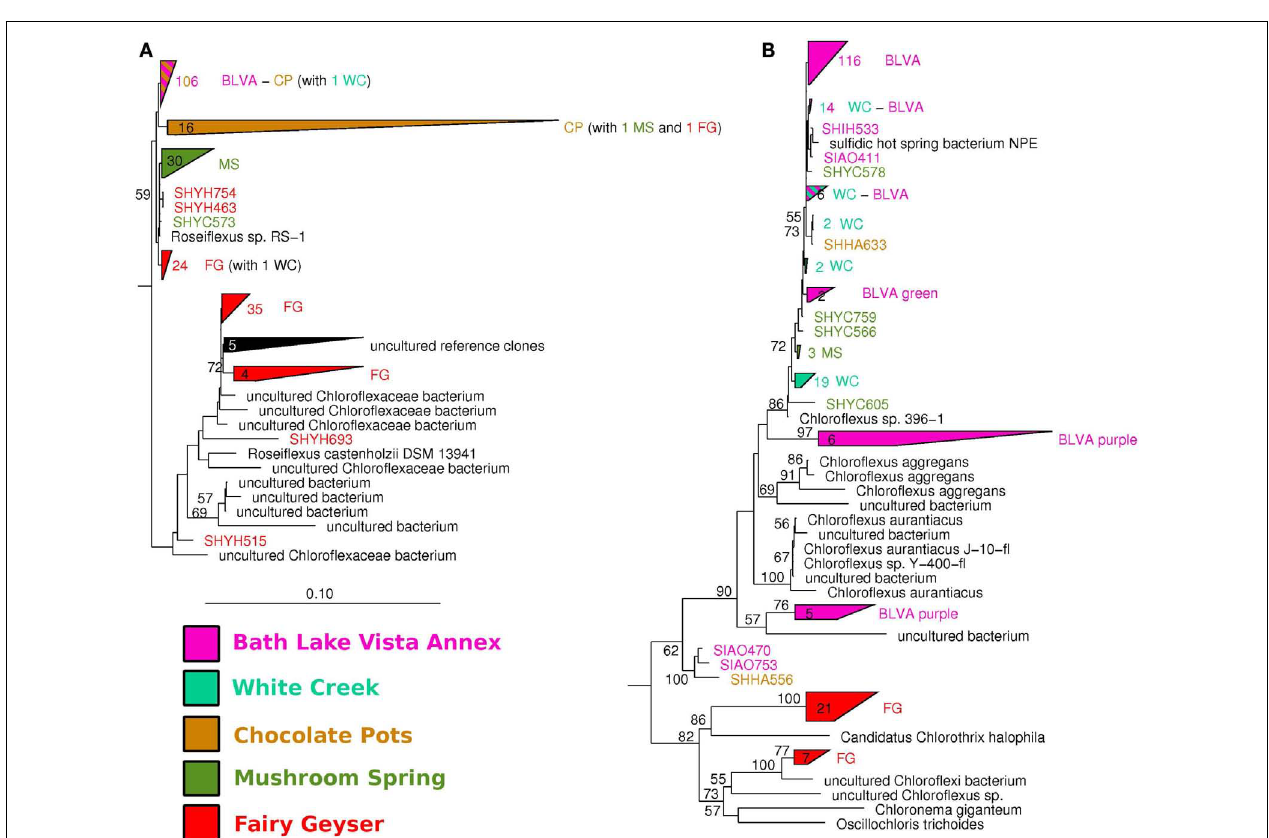
bacteriochlorophyll c . Sequences are color coded according to spring origin, and numbers adjacent to polygons indicate the number of clones in each clade. Bootstrap support for ≥ 50% of 1000 replicate trees are shown at